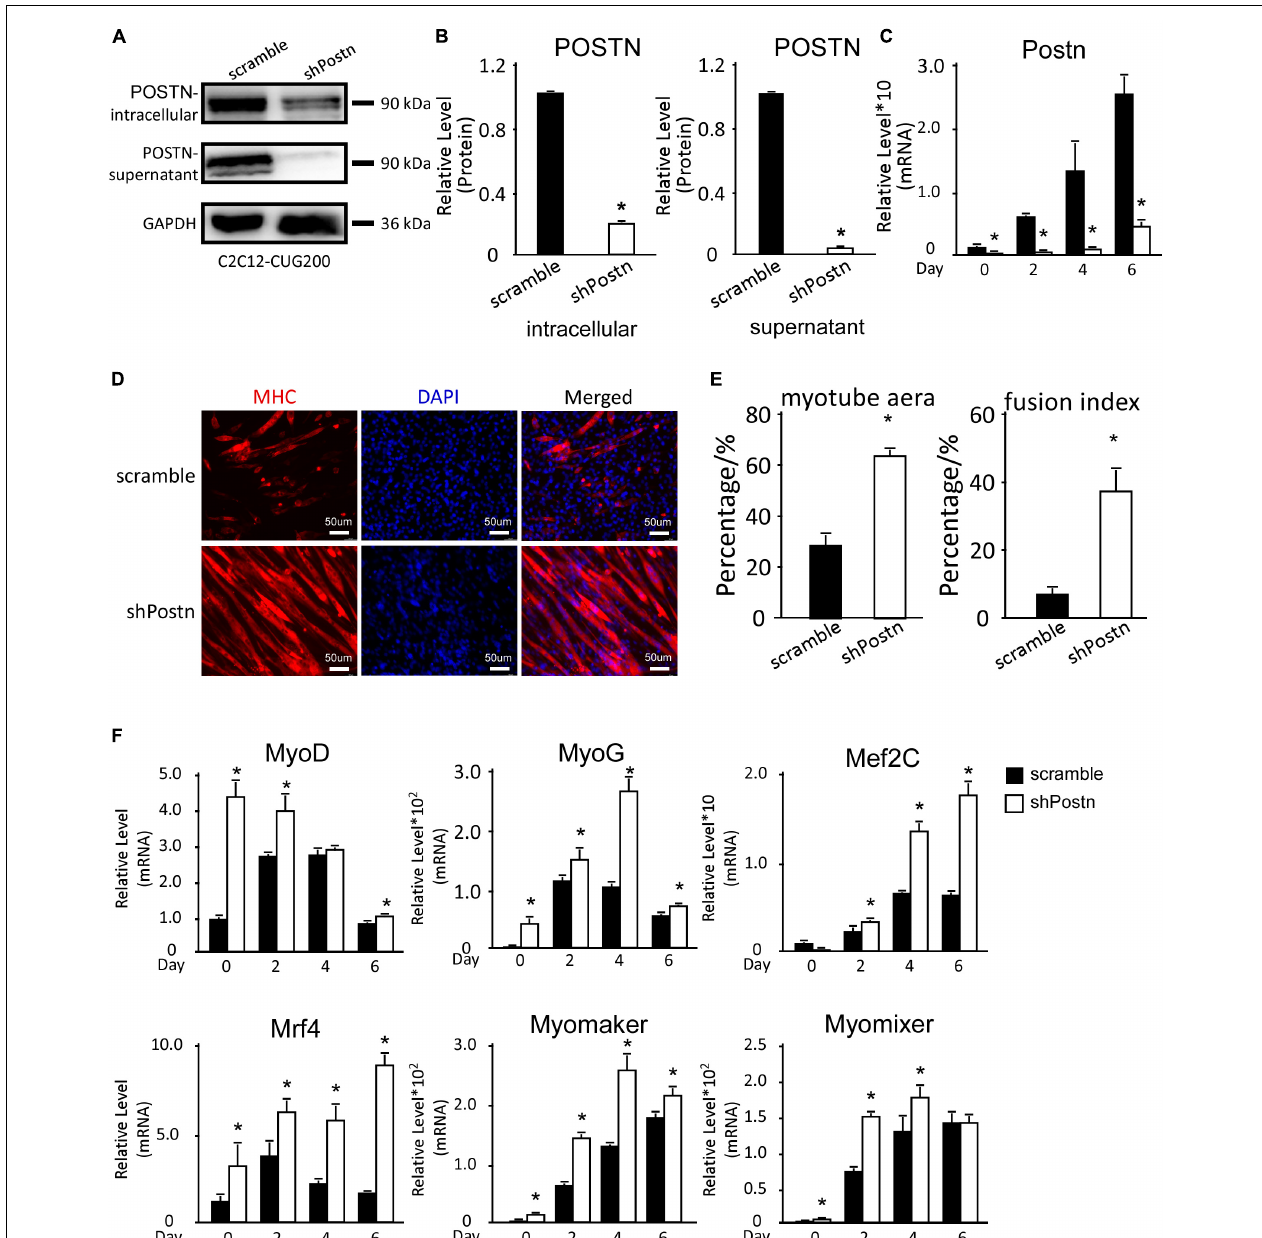
FIGURE 4 | Periostin knockdown rescued the myogenesis defects in DM1 myoblast cells. (A) Postn knockdown in DM1 myoblast cells (C2C12 GFP-CUG200) verified by western blotting. (B) Gel band intensities from panel (A) quantified using ImageJ software. Values were normalized to GAPDH. (C) Expression levels of Postn during differentiation in both scrambled control and Postn -knockdown groups, measured by RT-qPCR. (D) Myotube formation in both scrambled control and Postn -knockdown groups, detected by immunostaining against MHC at differentiation day 6. (E) Myotube area and fusion index in both groups quantified using ImageJ software. (F) Expression levels of MRFs ( MyoD , MyoG , Mef2C , and Mrf4 ) and fusion markers ( Myomaker and Myomixer ) in both groups, measured by RT-qPCR. All expression levels were normalized to the values of the scrambled control at day 0. Scramble, scrambled control DM1 myoblast cells; shPostn, Postn -knockdown DM1 myoblast cells; * P <